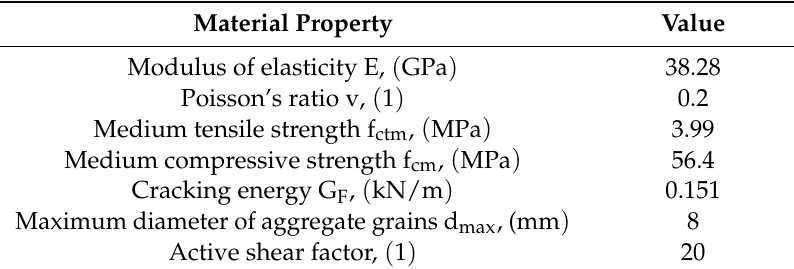
Table 7. Concrete material data for FEM calculations.